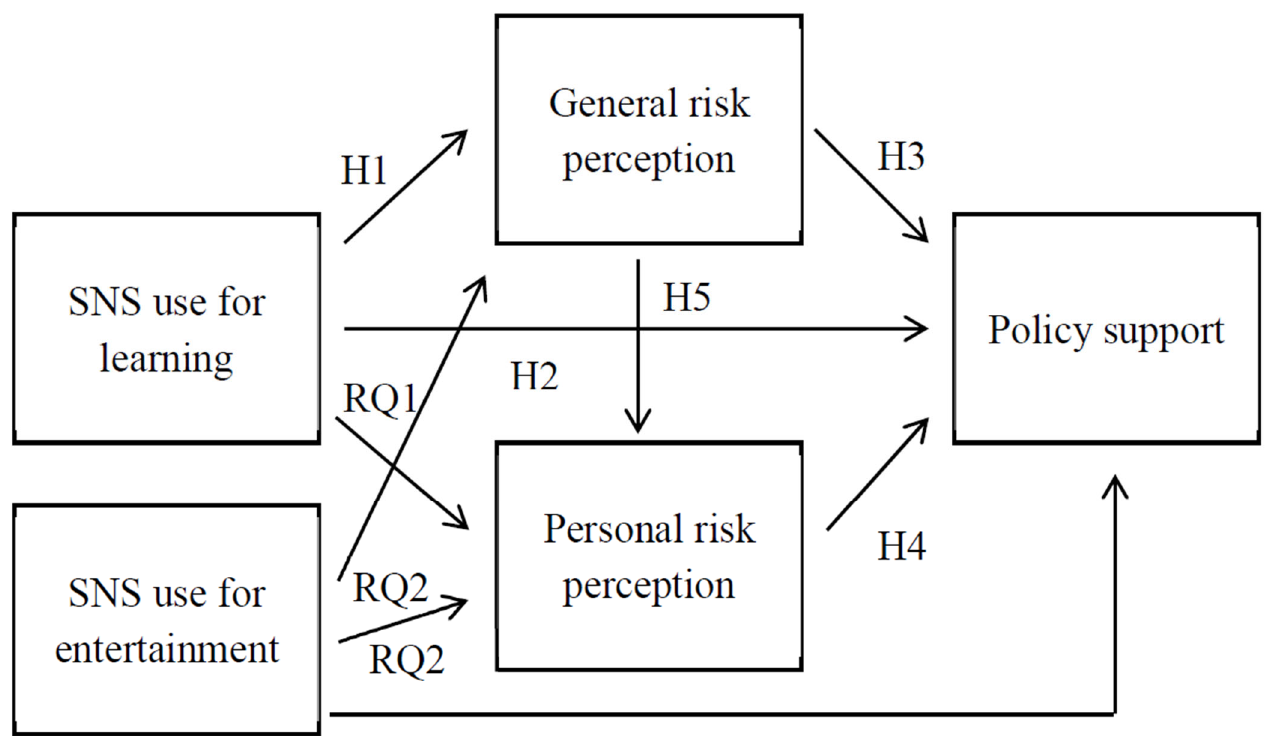
Figure 1. Hypothesized model of the study.